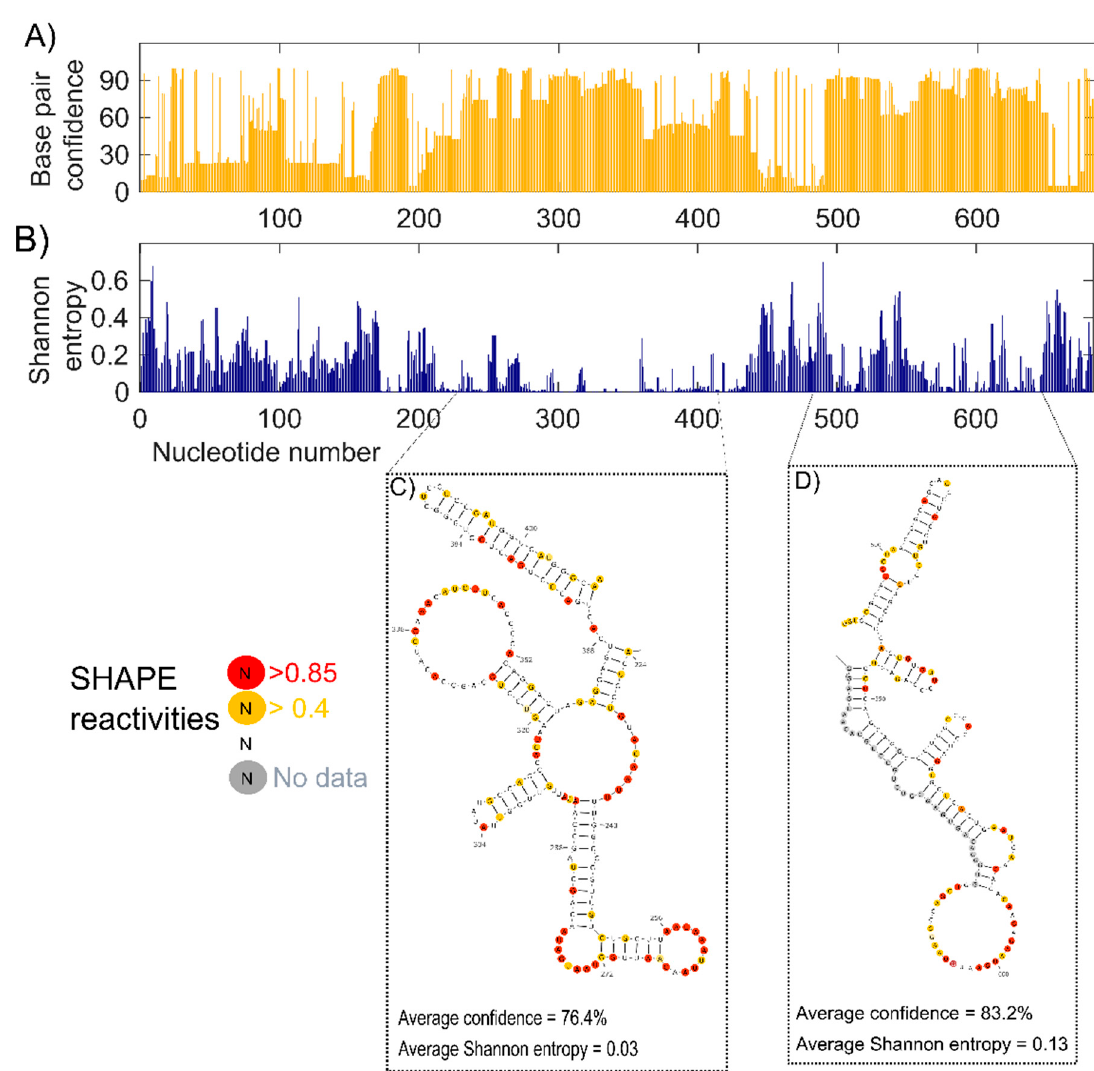
Figure 4. Confidence estimation and Shannon entropy of lncTCF7. ( A ) Confidence estimates of each nucleotide in our structural model of lncTCF7 calculated using jackknife resampling. ( B ) Shannon entropy values of each nucleotide in lncTCF7. Examples of two regions with high confidence and low Shannon entropy are shown in ( C , D ). SHAPE reactivities are highlighted as depicted in the legend (see Figure 3 caption for details).